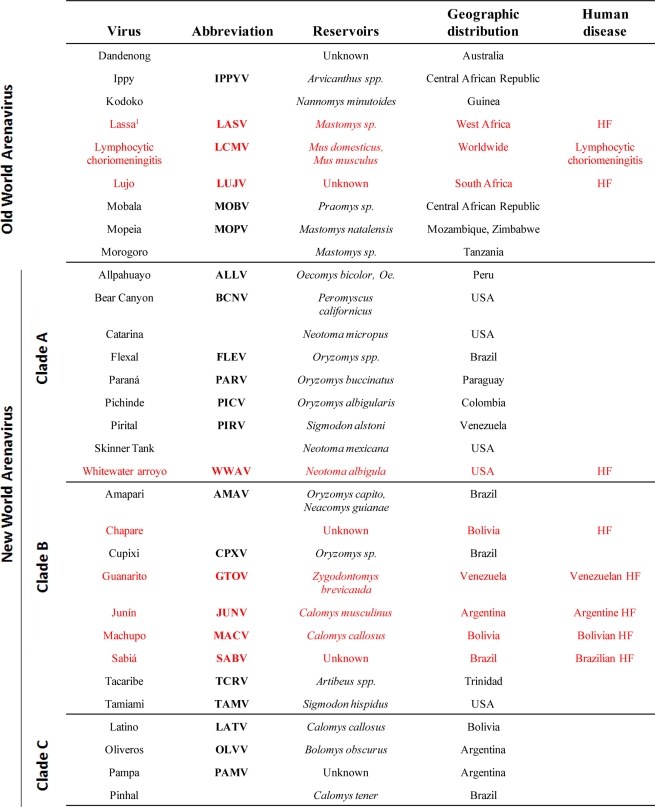
Members of the Arenaviridae family. 1Arenaviruses known to cause disease in humans are indicated in red.